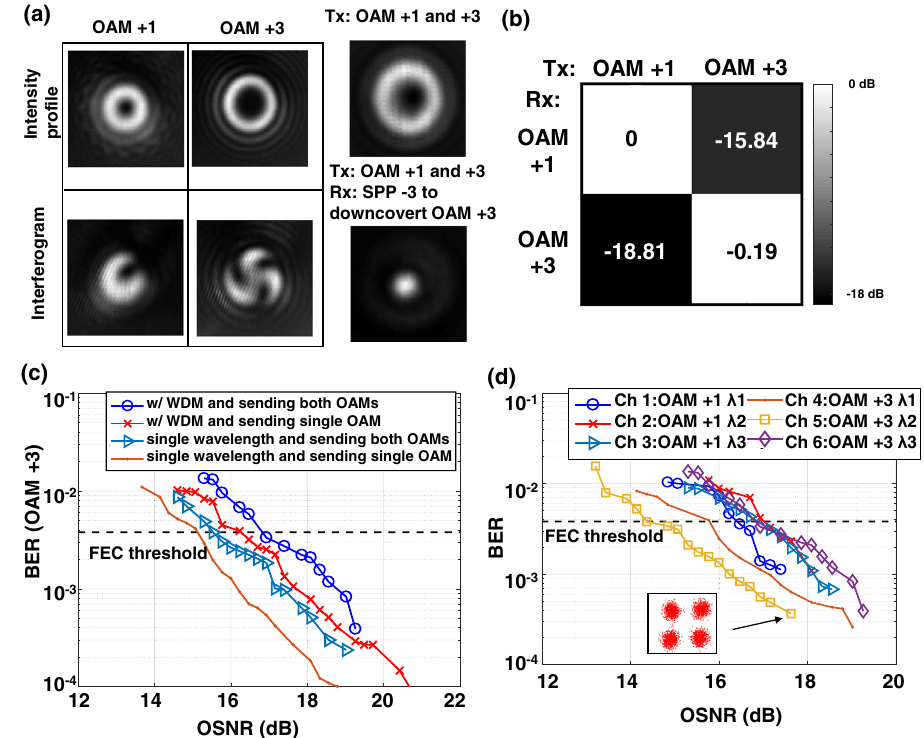
Fig.5|Demonstrationofa300Gbit/smid-IRFSOcommunicationsystemusing WDMandacombinationofWDMandMDM.a Measuredbeampro fi leofthemid- IR OAM beams. Intensity pro fi le and interferogram with a Gaussian beam of the OAM+1 and OAM+3 beam, respectively. Intensity pro fi le of the data-carrying multiplexedOAM+1and+3beams.Intensitypro fi leofthemultiplexedOAMbeam